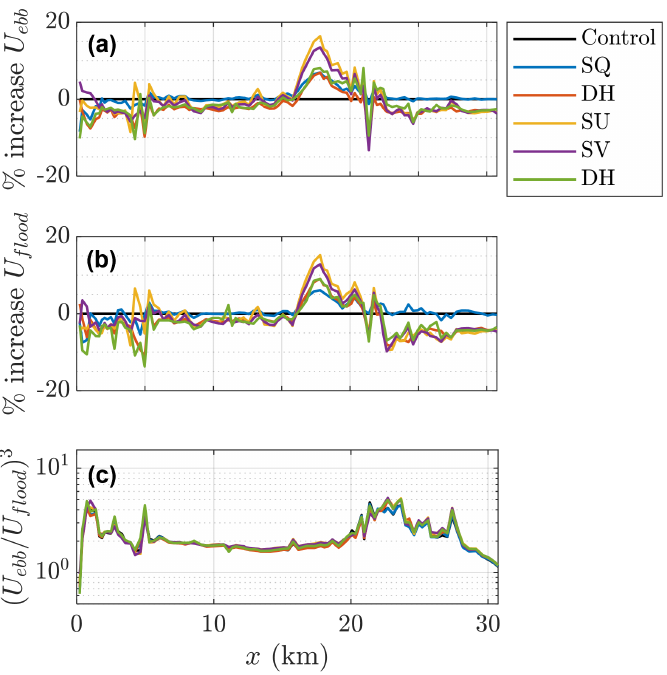
Figure 9. Percent increase in average streamwise velocity during ( a ) peak ebb tide U ebb and ( b ) peak flood tide U flood from the control as a function of distance up the main channel from inlet dx (Figure 1). ( c ) Cubed ratio of U ebb / U flood as a function of dx